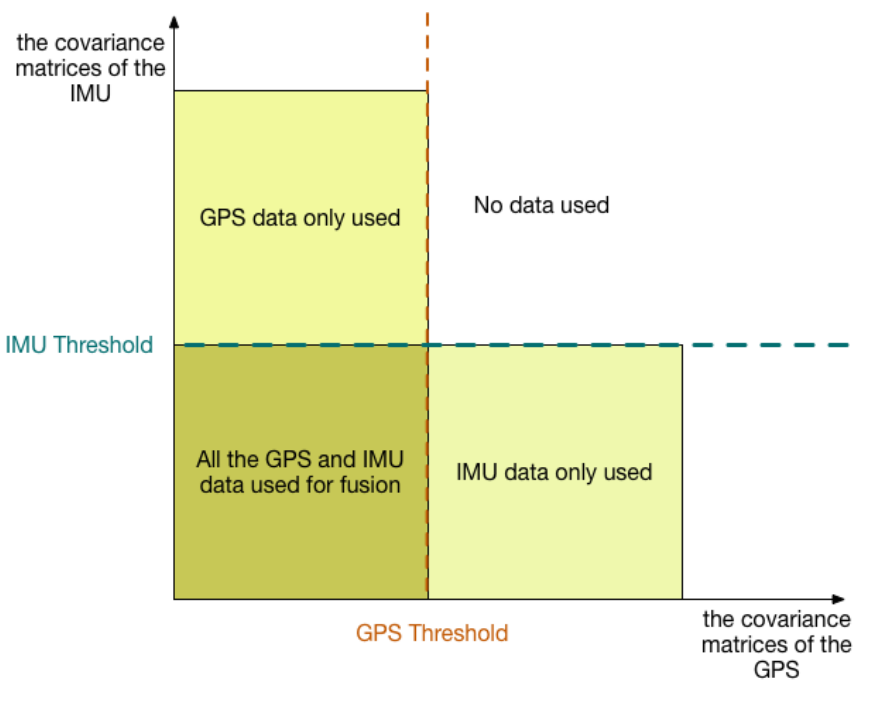
Figure 4. Sensors validity domains of GPS + IMU